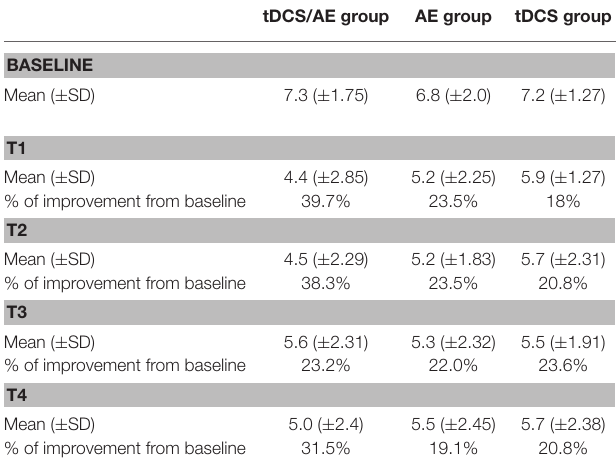
TABLE 2 | Mean and standard deviation values of primary outcome